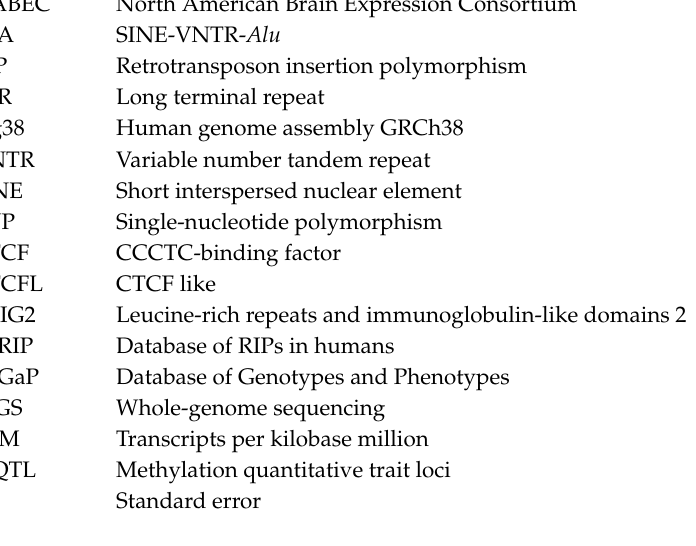
e ff ects of SVA_LRIG2 genotype in RNA-seq and CpG methylation data for NABEC individuals, a total of 17 tests were performed: 2 RNA transcripts ( LRIG2 and LRIG2-DT ) and 15 CpG probes were examined. The 0.05 alpha significance level for these linear regression analyses was therefore